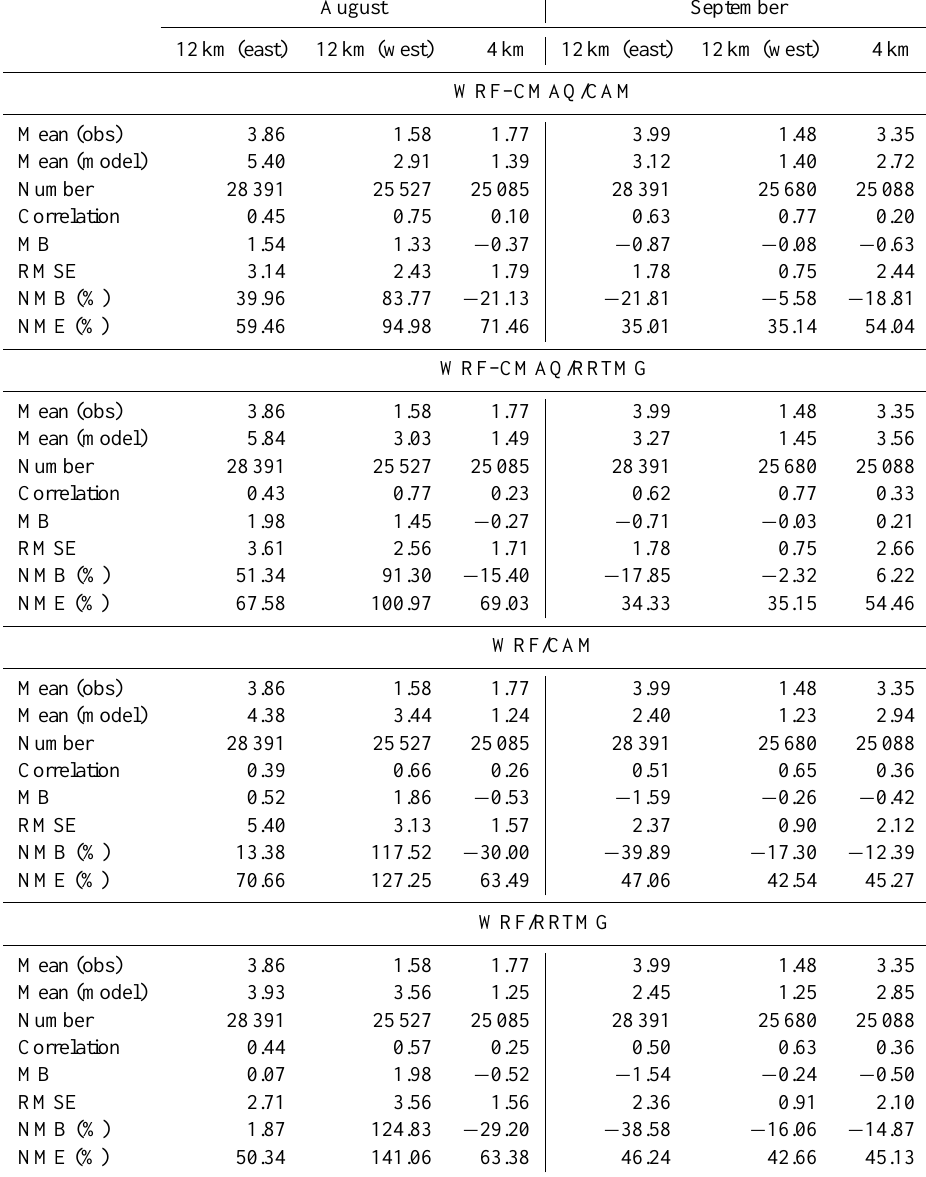
Table 13. Comparison of observation (PRISM) and models (WRF–CMAQ/CAM, WRF–CMAQ/RRTMG, WRF/CAM and WRF/RRTMG) for monthly precipitation (inchmonth − 1 ) over the land of the eastern US and the western US from 12km resolution simulations and over the eastern Texas domain from the 4km resolution simulations in August and September of